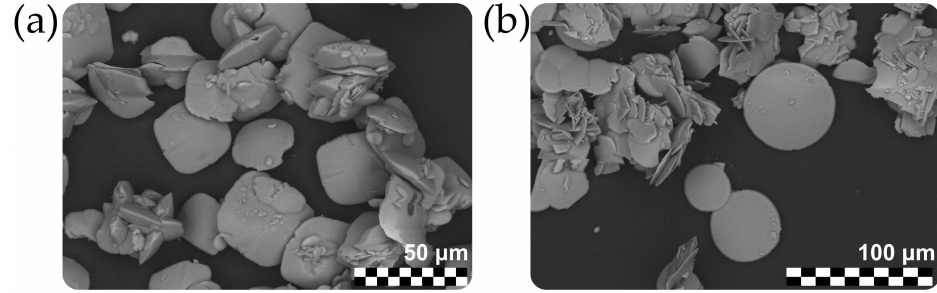
Figure 13. SEM images of SM